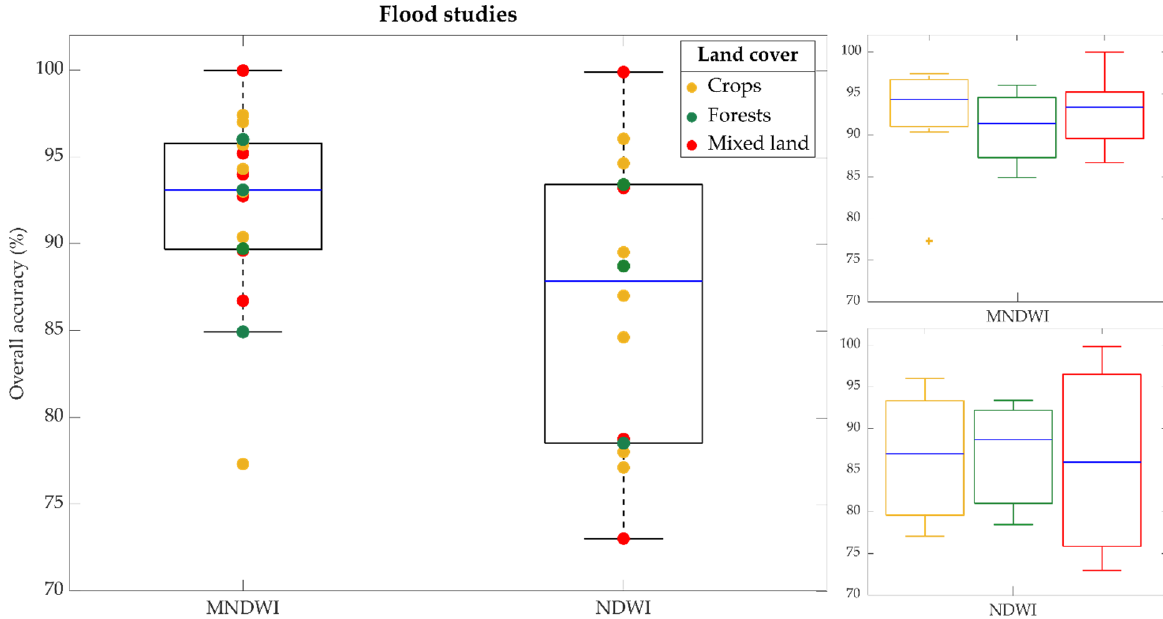
Figure 5. Results of the performances of the MNDWI and NDWI in detecting flooded areas in different land cover settings, expressed in terms of overall accuracy (OA). The blue line represents the median value of the general OA values of MNDWI and NDWI ( left panel ) and of the OA values of the MNDWI and NDWI in each land cover category ( right panels ).